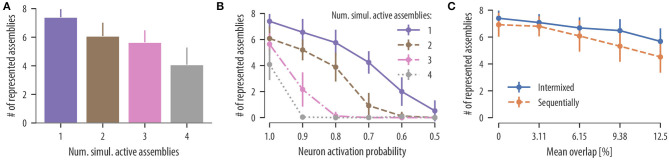
Synaptic clustering depends on input statistics. (A) Mean number of represented assemblies as a function of the number of simultaneous active assemblies. The difference in the mean number of represented assemblies for two and three simultaneous active assemblies were not significant. However, the number of represented assemblies significantly decreased compared to temporally isolated pattern presentations in all cases [F(3, 96) = 53.9, p < 0.0001, one-way analysis of variance (ANOVA); p < 0.0001, one active assembly vs. two simulations active assemblies, 1 vs. 3, 1 vs. 4, 2 vs. 4, 3 vs. 4; not significant (ns) p = 0.35, 2 vs. 3; n = 25 trials]. These results show that the rewiring mechanism segregates uncorrelated input assemblies onto different branches even when a medium number of assemblies are activated simultaneously. (B) Mean number of represented assemblies as a function of the assembly neuron activation probability (mean and SD over 25 independent trials). Results are shown for temporally isolated pattern presentations (violet solid line), two simultaneous active assemblies (brown dashed line), three simultaneous active assemblies (pink dashed dotted line), and four simultaneous active assemblies (gray dotted line). In all four cases, the number of represented assemblies significantly decreased at a neuron activation probability of 0.9 [t(24) = 5.09, p < 0.0001, one active assembly, activation probability of 1.0 vs. activation probability of 0.9; t(24) = 4.99, p < 0.0001, two active assemblies; t(24) = 10.8, p < 0.0001, three active assemblies; t(24) = 19.2, p < 0.0001, four active assemblies, paired t-test]. (C) Mean number of represented assemblies as a function of the mean overlap between a given pair of assemblies (mean and SD over 25 independent trials). Results are shown for intermixed pattern presentations (blue solid line) and for patterns presented in a sequential manner as in Figure 4 (orange dashed line). In both cases, the number of represented assemblies significantly decreased for a mean assembly overlap of 6.15 % [t(24) = 3.84, p = 0.0008, intermixed, disjoint assemblies vs. non-disjoint assemblies with mean overlap of 6.15 %; t(24) = 2.87, p = 0.008, sequentially, paired t-test].